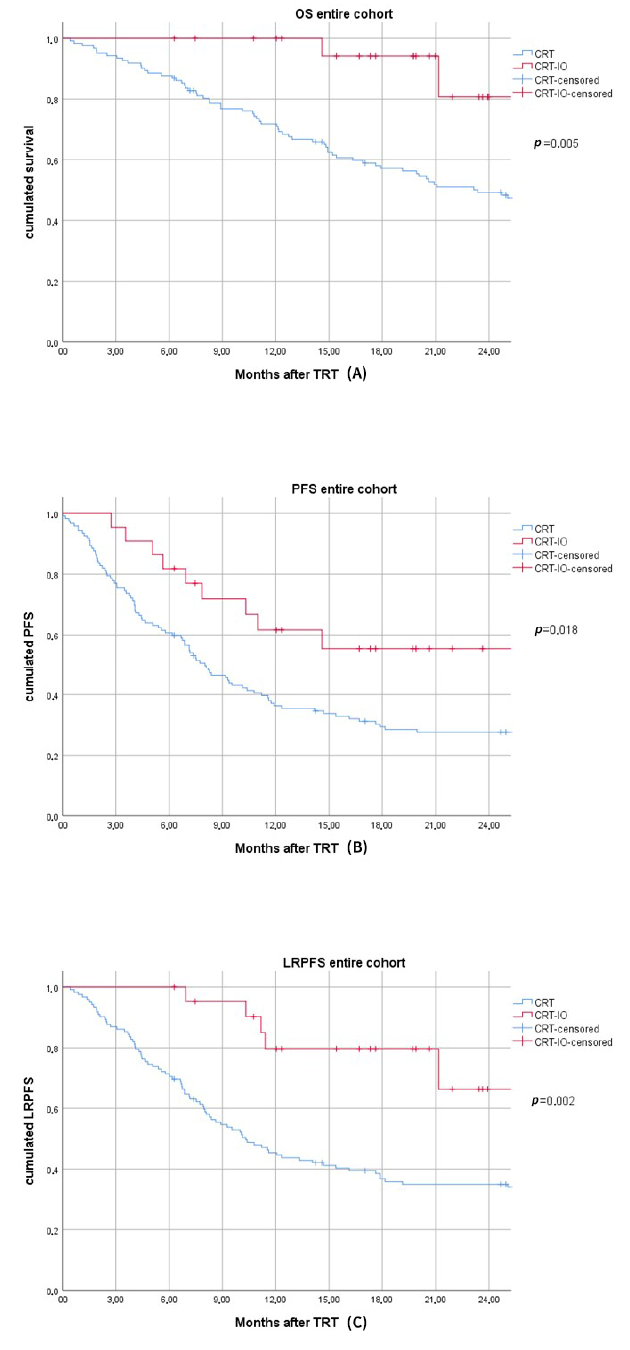
Figure 1. ( A ). Kaplan–Meier curve for overall survival (OS) of chemoradiotherapy (CRT) versus chemoradiotherapy followed by durvalumab maintenance treatment (CRT-IO). ( B ). Kaplan–Meier curve for progression-free survival (PFS) of chemoradiotherapy (CRT) versus chemoradiotherapy followed by durvalumab maintenance treatment (CRT-IO). ( C ). Kaplan–Meier curve for local-regional- progression-free-survival (LRPFS) of chemoradiotherapy (CRT) versus chemoradiotherapy followed by durvalumab maintenance treatment (CRT-IO). Other significant negative factors for OS in univariate analysis were PTV ≥ 700cc ( p = 0.045) and histology non-AC ( p = 0.023). Age > 65 years ( p = 0.054), male gender ( p = 0.053) showed a trend and absence of simultaneous chemotherapy had no significant impact on OS ( p =